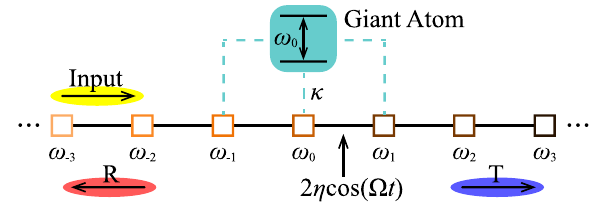
Fig. 1 Schematics for a 1D dynamically-modulated coupled- resonator waveguide coupling to a two-level giant atom. The excited source is injected into the waveguide (yellow). After it interacting with the giant atom, the fi eld is transmitted (blue) or re fl ected